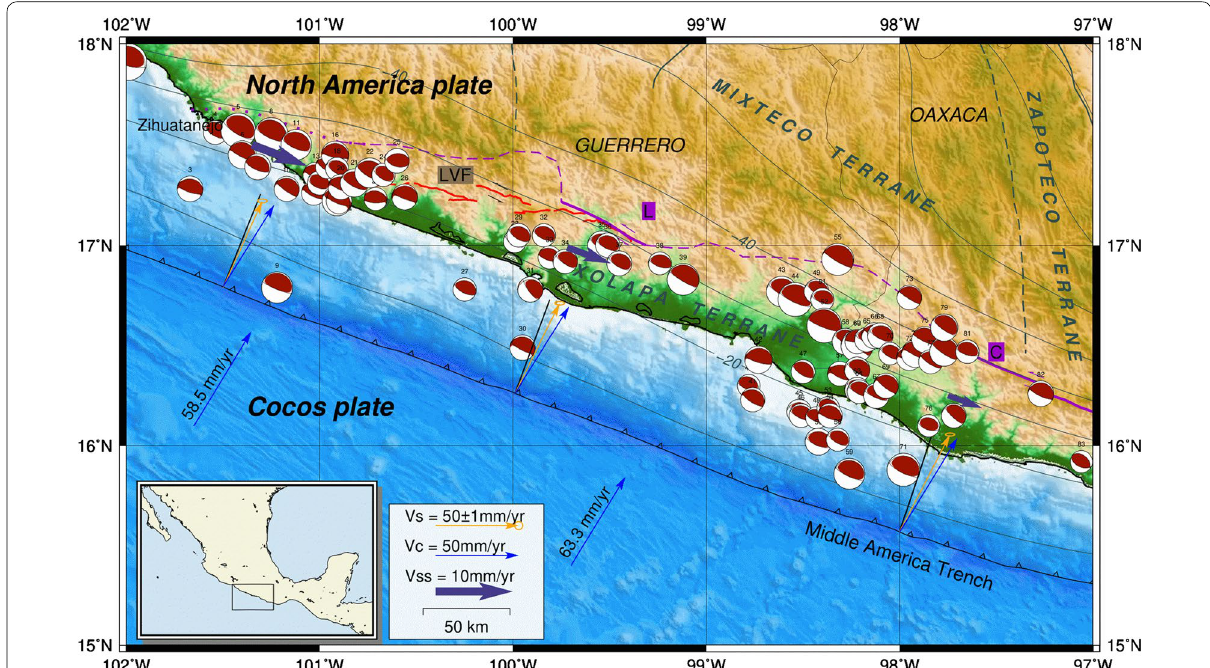
Fig. 3 Earthquakes from the Global CMT catalog. Selected subduction thrust events from the Global CMT catalog for 1976–2016. Other annotations are the same as in Fig. 1